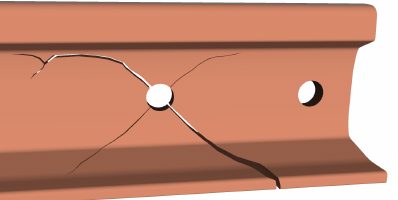
Figure 6. Three-dimensional representation of bolt-hole cracks.